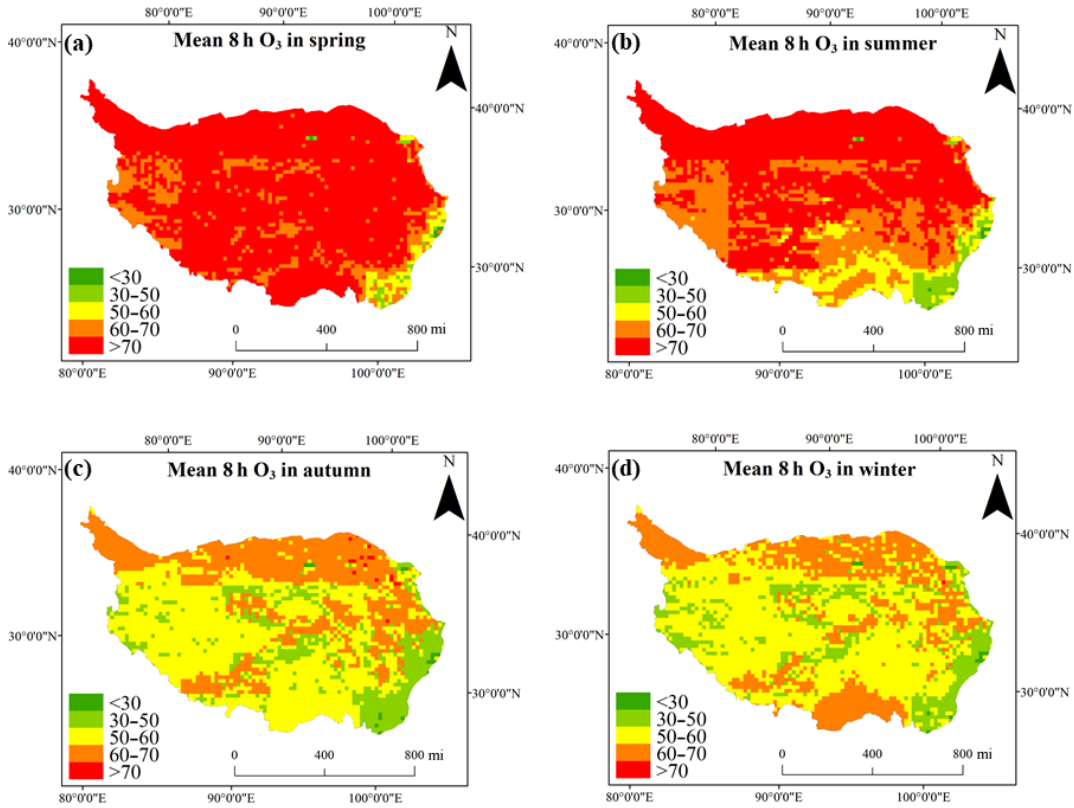
Figure 9. The seasonal variability in estimated 8h O 3 level across the Tibetan Plateau. Panels (a–d) represent the predicted 8h O 3 concen- trations in spring, summer, autumn, and winter, respectively. Table 4. The estimated 8h O 3 concentration in 19 prefecture-level cities over the Tibetan Plateau during four seasons, including spring, summer, autumn, and winter.